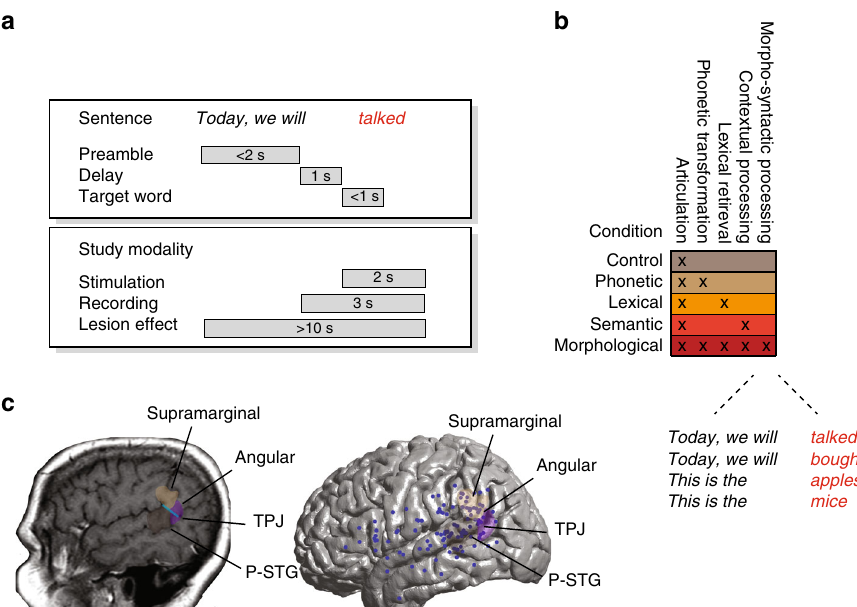
Fig. 1 Task design and distribution of stimulation sites. a On each trial, participants were presented (auditorily) with a preamble such as “ Today, we will ... ” . After a 1-s delay, they were given a target word, presented visually (e.g., “ talked ” ) that they had to produce out loud either as presented or after manipulating it in some way. b Several target word manipulations were introduced in order to test for the speci fi c effect of stimulation on basic sensory perceptual processing and articulation (control condition), the ability to recognize and phonetically transform the target word (phonetic condition), the ability to retrieve lexical information from memory (lexical condition), and, more broadly, the ability to understand language and respond with the appropriate semantic knowledge (semantic condition). Additional comparisons included nouns vs. verbs, regular vs. irregular in fl ections, and suf fi x additions vs. subtractions (Supplementary Table 2). A few representative examples of sentence preambles (black italic) and target words (red italic) in the critical syntactic condition are provided. c Here, we focused on the posterior superior temporal cortex, which borders the supramarginal and angular gyri (P-STG refers to the posterior-most aspect of the superior temporal gyrus). The anatomical temporal – parietal junction (TPJ) is drawn in blue. Individual, stereotactically identi fi ed stimulation sites are shown by dark-blue dots ( n = 113) on the right. Due to surgical constraints, however, not all stimulated sites were comprehensively tested ( n = 54, “ Methods ”